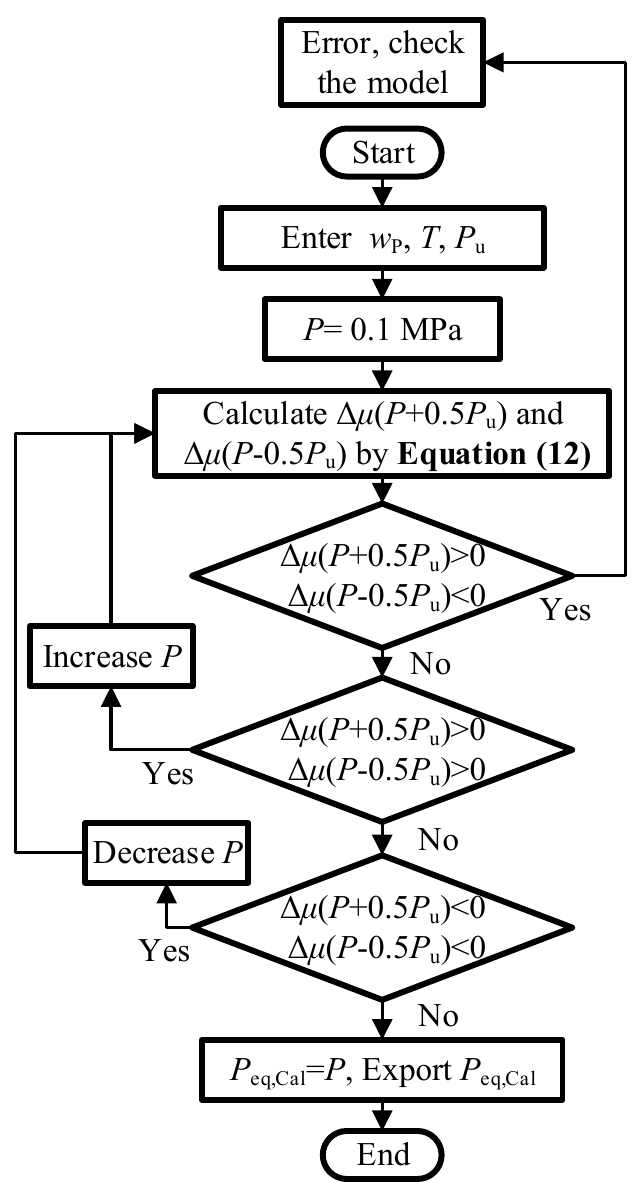
Figure 2. Schematic diagram of the calculation of P eq,Cal .